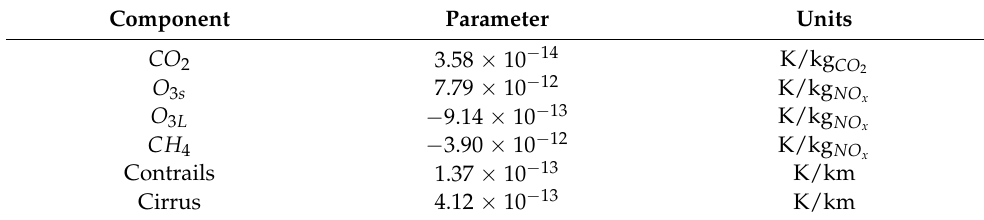
Figure 3. Forcing factor as a function of altitude. Adapted from [17]. Table 1. SGTP indeces. Adapted from